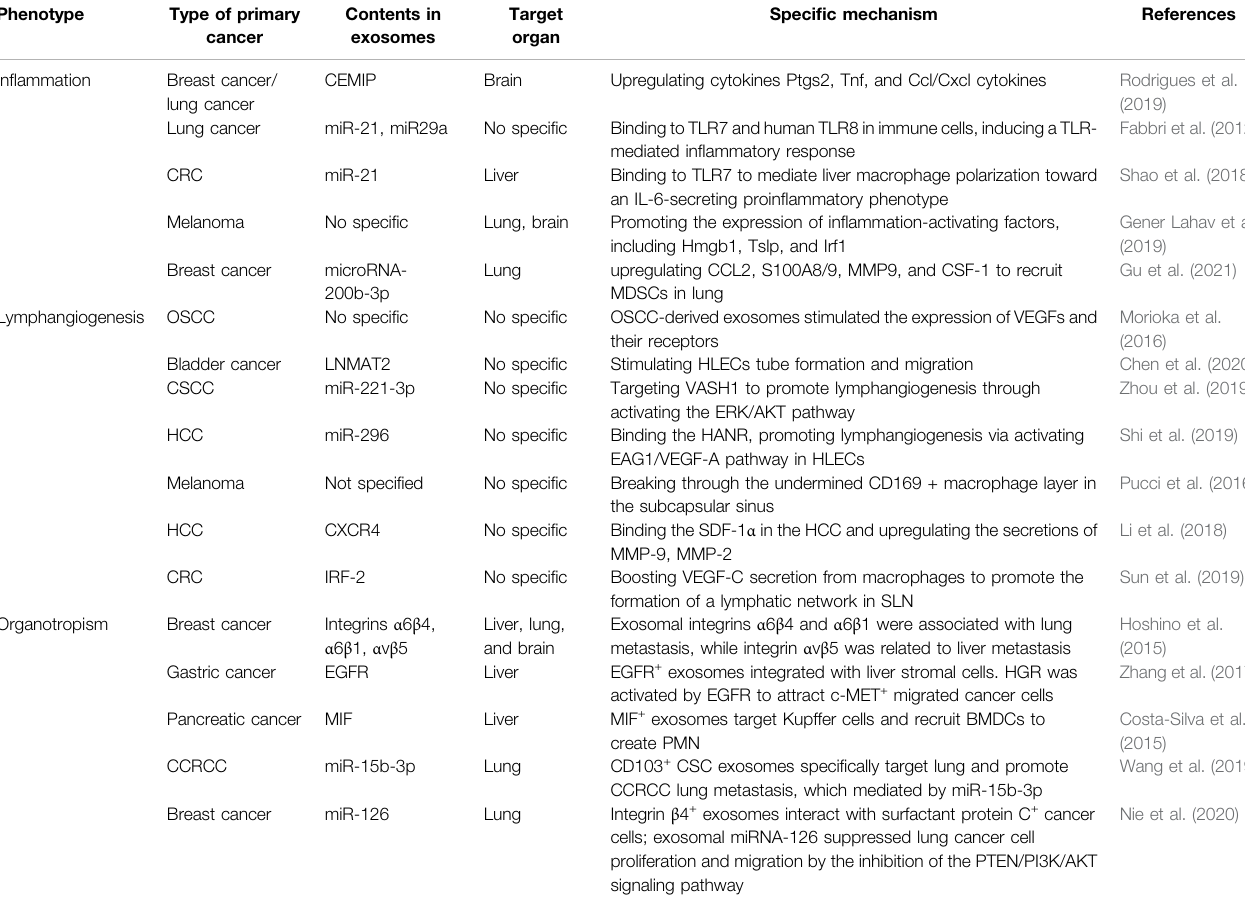
TABLE 1 | The role of exosomes in in fl ammation, lymphangiogenesis, and